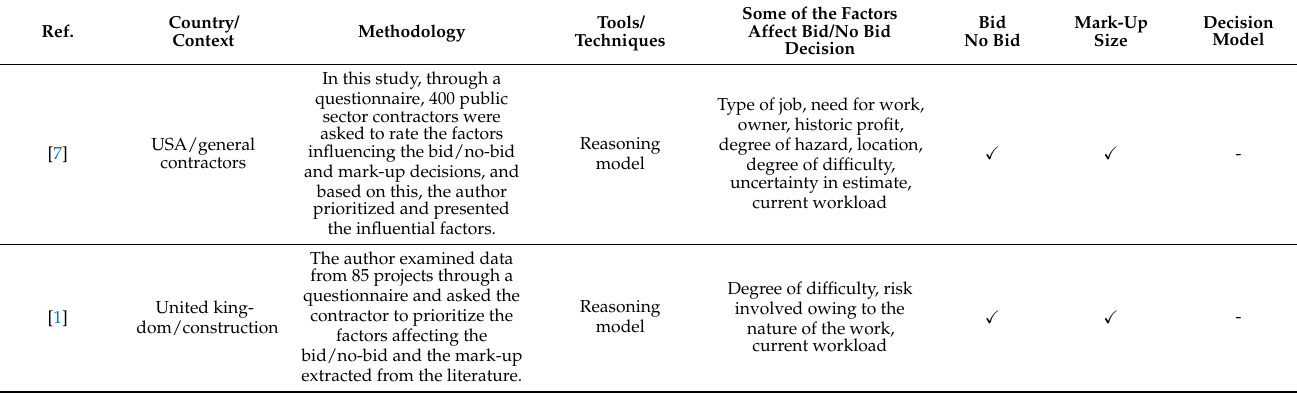
Table 1. Comparative study of selected previous research studies and the current study.